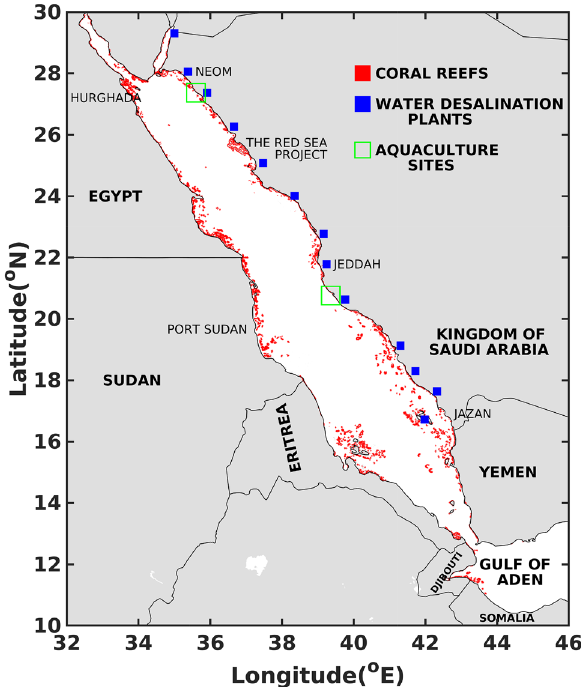
Figure 1. General map of the Red Sea illustrating the locations of coral reefs, largest cities, developments and installations along the coastlines. The figure was created on Matlab-r2020b (https:// matlab- r2020b. softw are. infor mer. com). Coral reefs data are from open database Ocean Data Viewer (https:// data. unep- wcmc. org/ datas